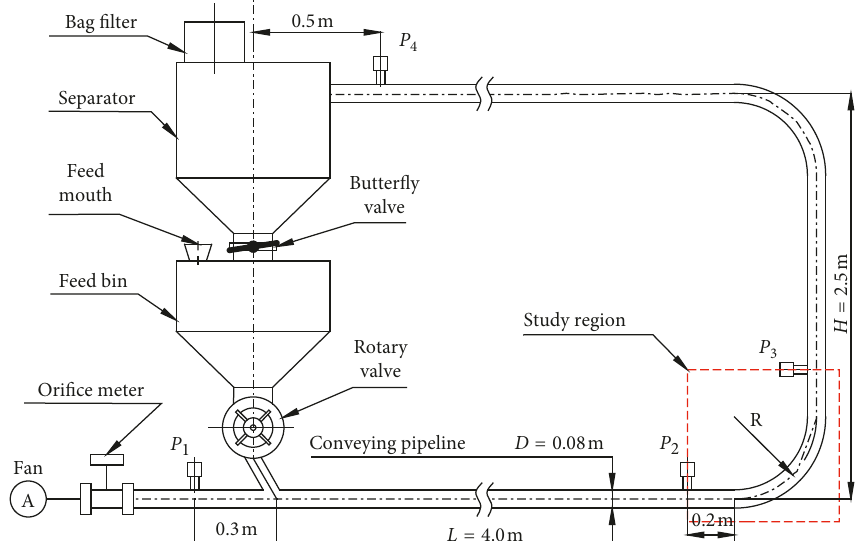
Figure 1: Diagram of experimental apparatus.